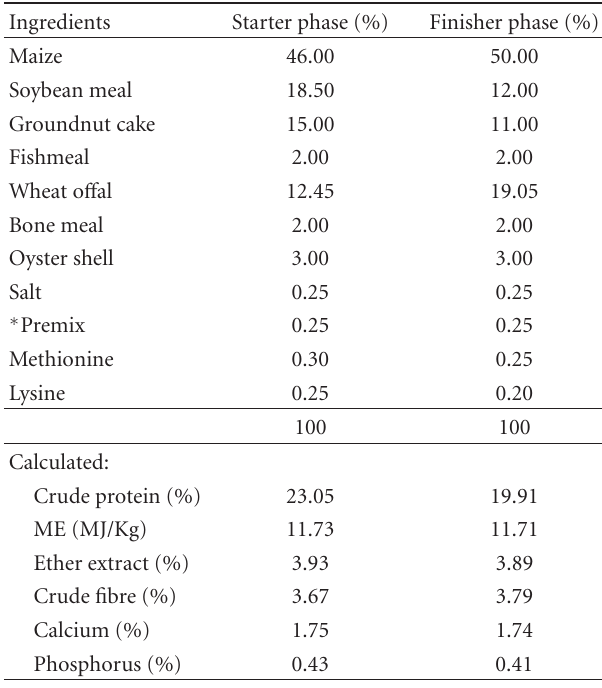
Table 3: E ff ect of honey on growth performance of broiler chickens during hot-dry season.